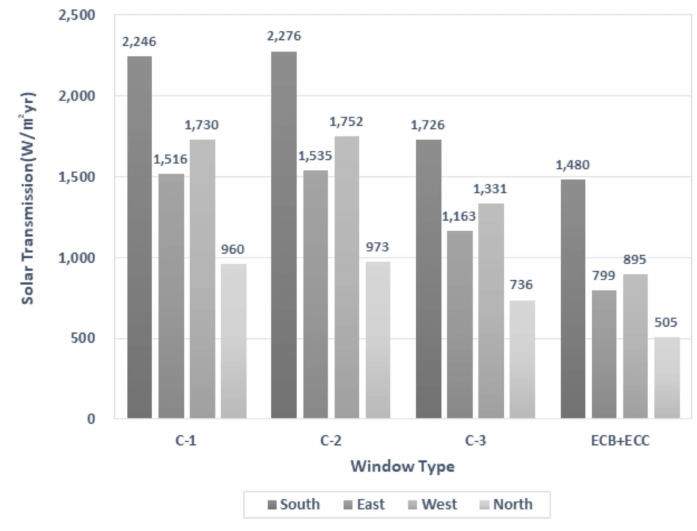
Figure 2. Annual solar transmission rate by orientation according to window type.